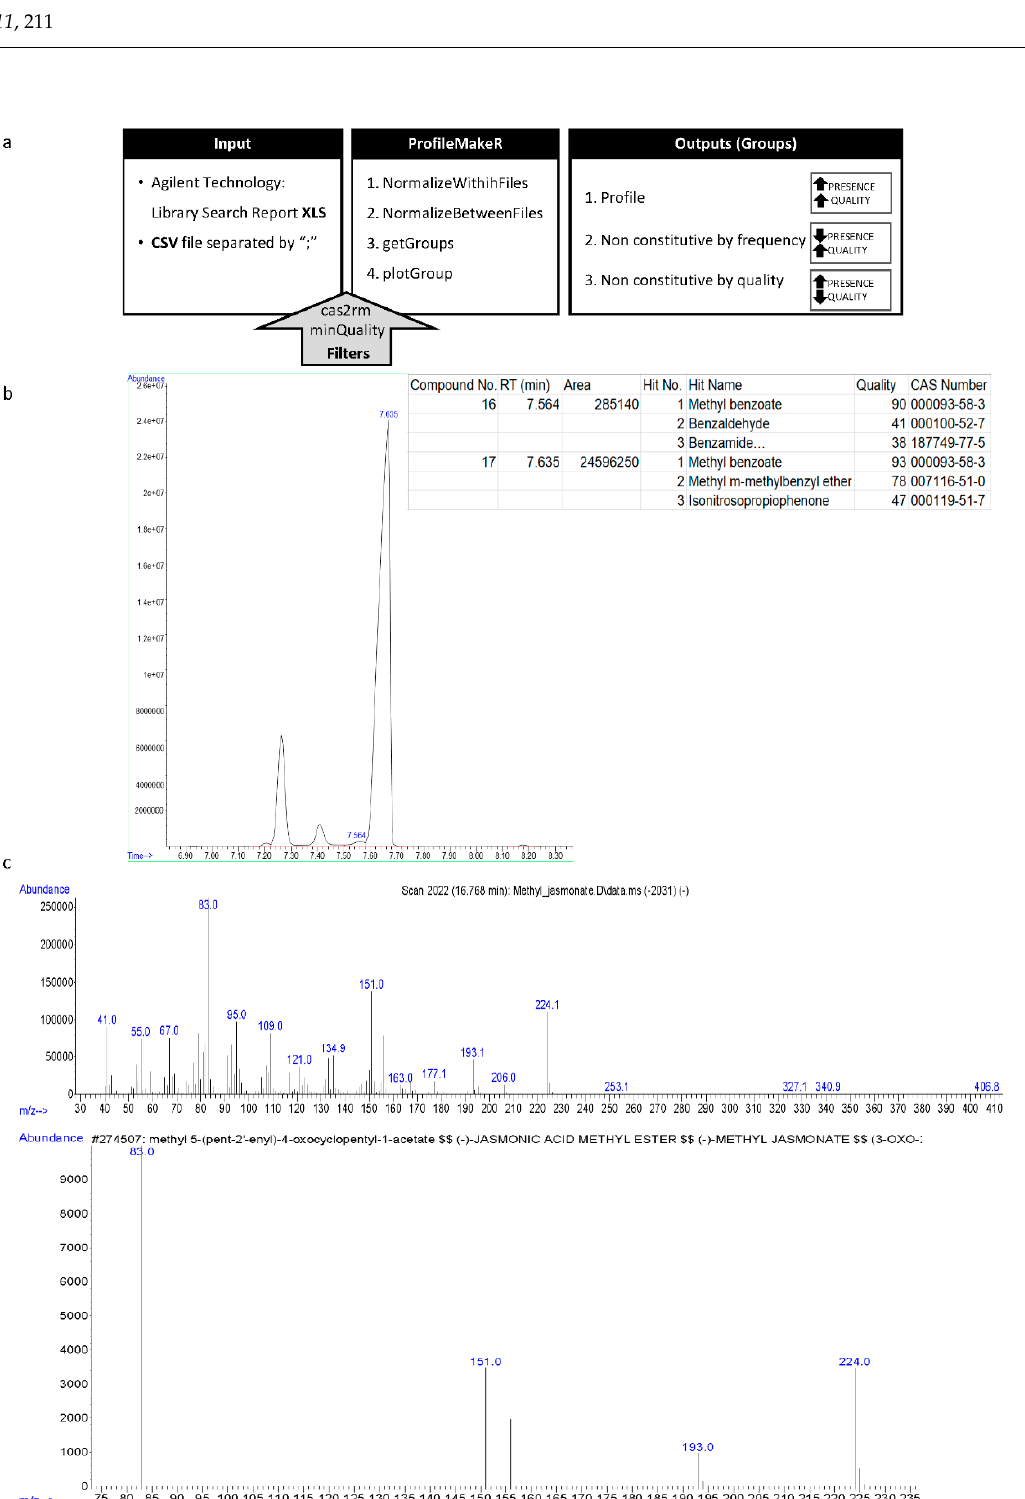
Figure 1. ( a ) gcProfileMakeR pipeline. This library accepts Excel (.xls) and. csv files as input data. The first function, NormalizeWithinFiles, reads the data and groups compounds with similar retention time (RT) and common CAS numbers. Users also can apply two filters: cas2rm (compound/s to exclude) and minQuality (minimum quality). NormalizeBetween- Files groups compounds with similar RT in all files, with the most representative CAS number. getGroups determines the constitutive and non-constitutive profiles (i.e., metabolic profile) by frequency and quality, which are chosen by the user. Finally, plotGroup creates a graphic the constitutive, non-constitutive by frequency and/or non-constitutive by quality. ( b ) A standard chromatogram where two close peaks are integrated separately by default and dataset corresponding to peaks, where the identity with highest probability of the peaks is the same, methyl benzoate (CAS number 93-58-3). ( c ) Mass spectra of methyl jasmonate (CAS No: 39924-52-2), a commercial standard (upper panel) and mass spectral database (lower panel) Willey10th-NIST11b.